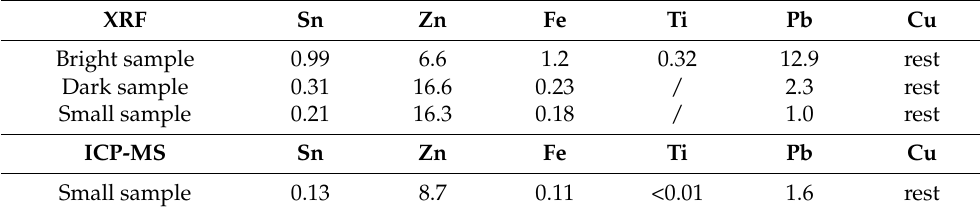
Table 1. Average chemical composition of the brass tiles measured by XRF and ICP-MS in wt.%. XRF Sn Zn Fe Ti Pb Cu Bright sample 0.99 6.6 1.2 0.32 12.9 rest Dark sample 0.31 16.6 0.23 / 2.3 rest Small sample 0.21 16.3 0.18 / 1.0 rest ICP-MS Sn Zn Fe Ti Pb Cu Small sample 0.13 8.7 0.11 <0.01